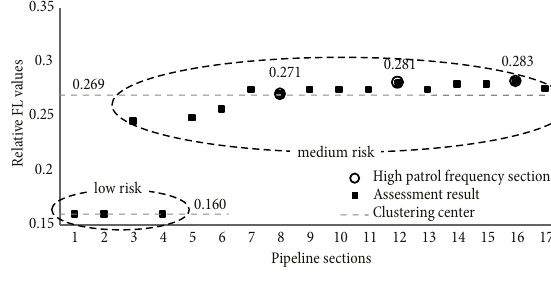
Fig. 11. The assessment results from RB-FSE model